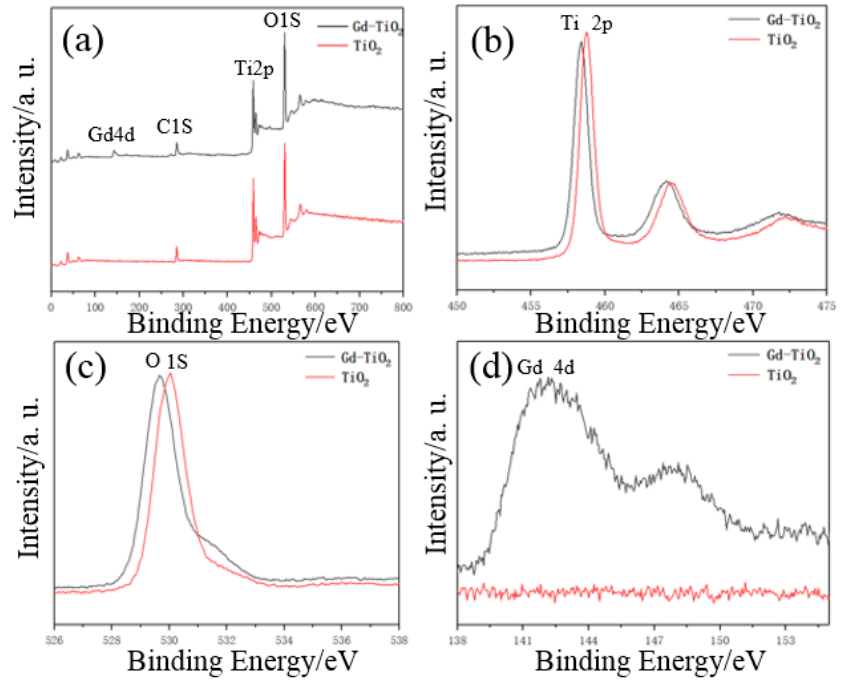
Figure 8. XPS of ( a ) full spectrum, ( b ) Ti2p, ( c ) O1S and ( d ) Gd4d.